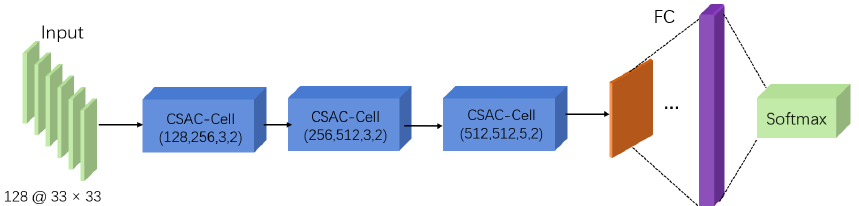
Figure 3. The detailed architecture of the proposed CSAC-Net.